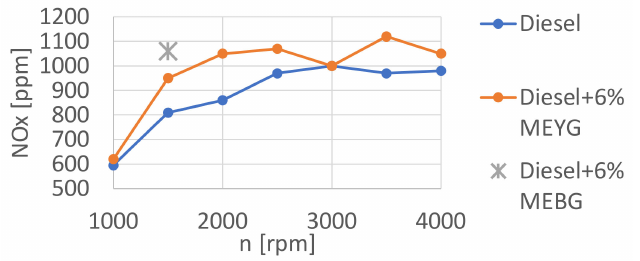
Figure 12. The NO x emissions at full engine load.